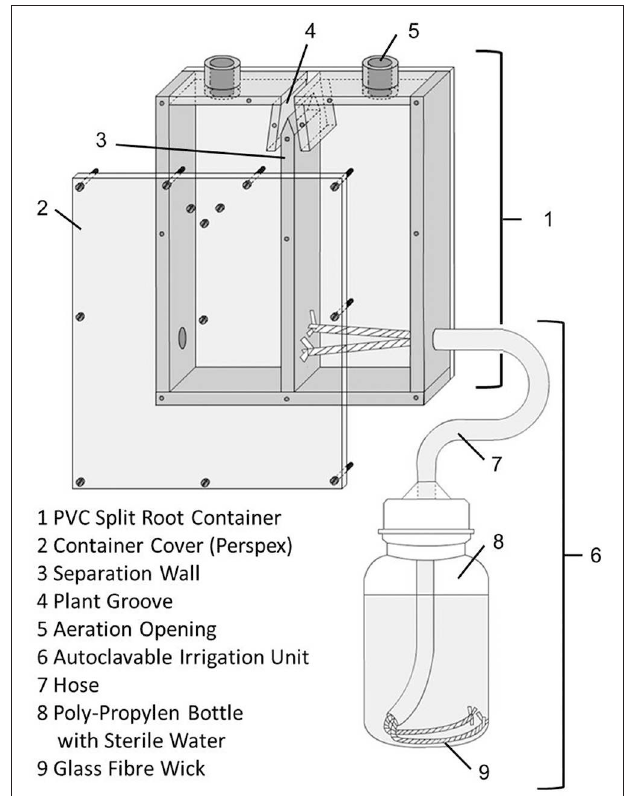
FIGURE 1 | Technical sketch of the split root container, outer dimensions were 18.0 × 15.6 × 2.6cm. Irrigation system only shown for the right